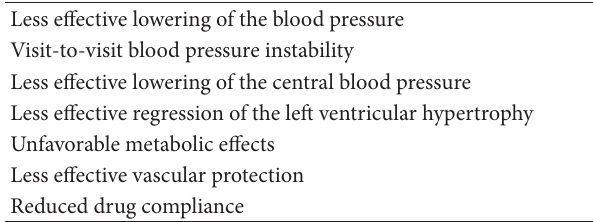
Table 1: Plausible reasons for beta-blockers being relatively ineffec- tive for the prevention of cardiovascular